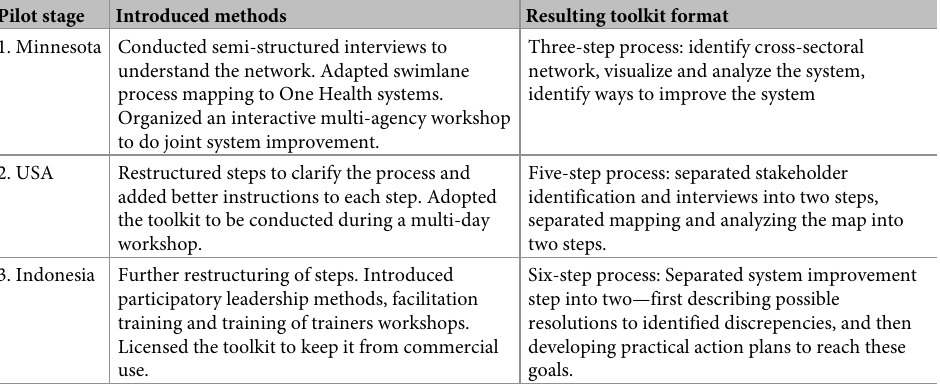
Table 1. OH-SMART development process results. Summary describing the stages of the iterative toolkit develop- ment process and their results. Pilot